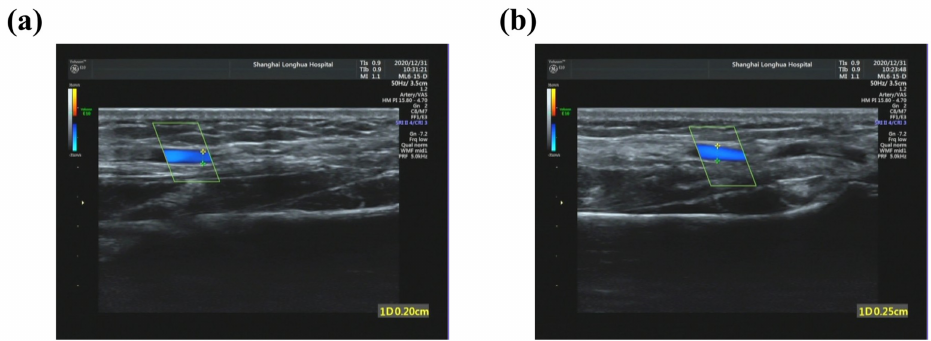
Figure 15. Diameter of Volunteer 1’s radial artery in diastole and systole was measured using an